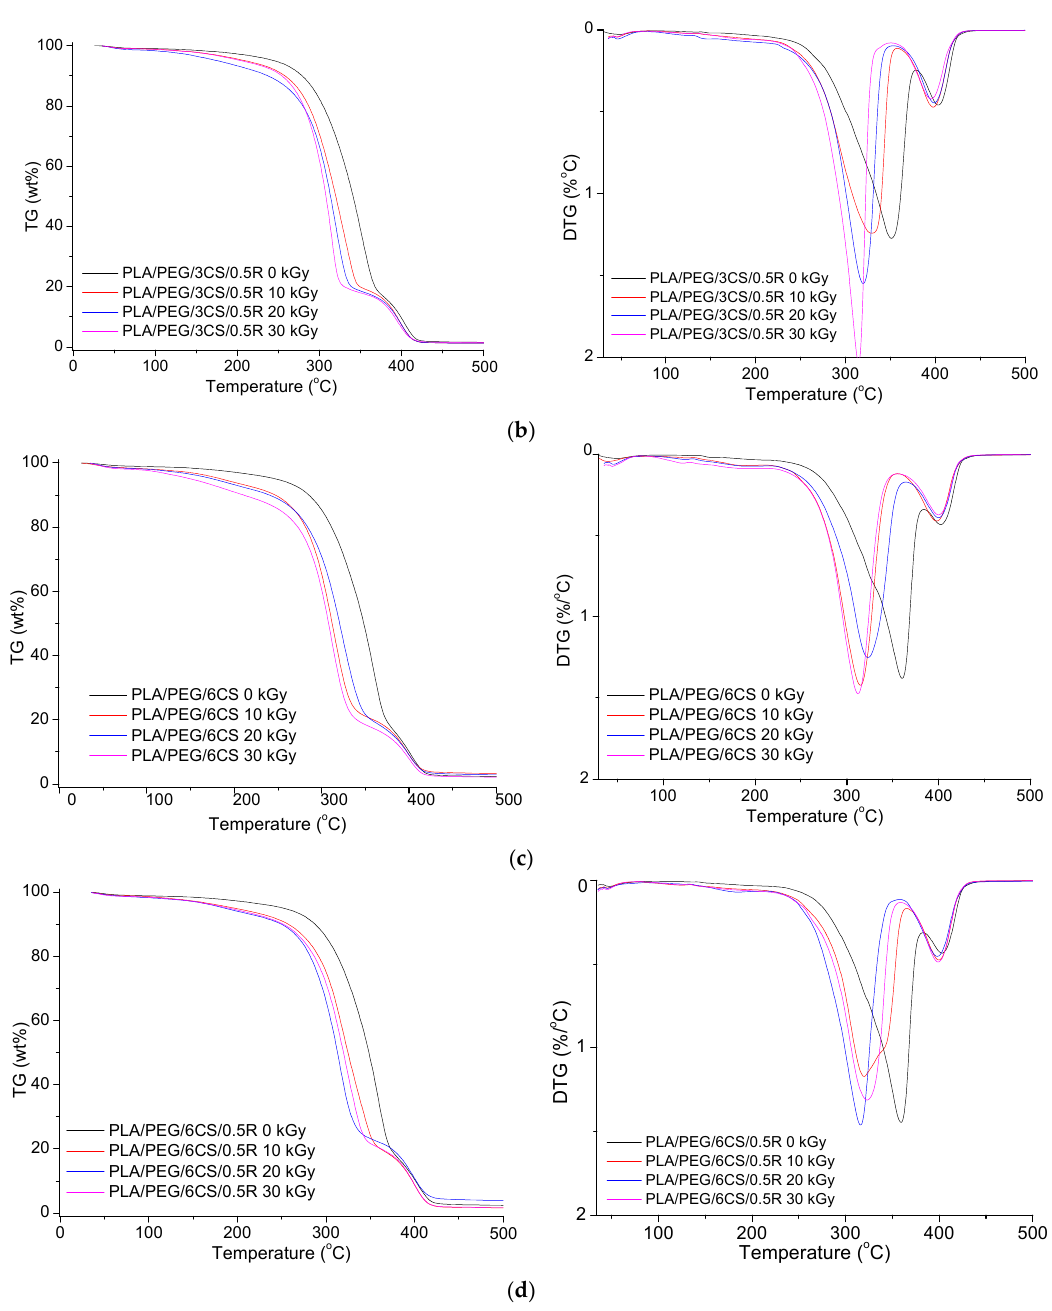
Figure 9. TG ( left ) and DTG ( right ) curves of the PLA/PEG/CS ( a , c ) and PLA/PEG/CS/R ( b , d ) non-irradiated and irradiated at 10, 20, and 30 kGy.